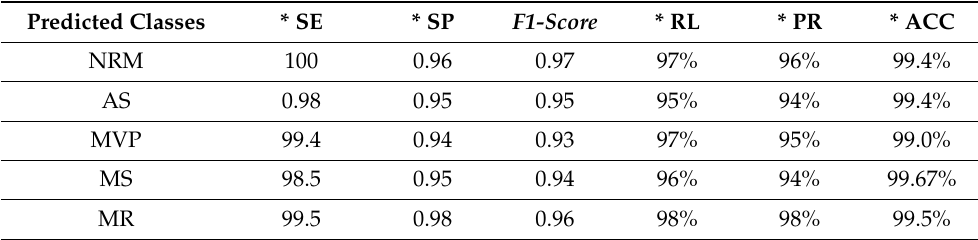
Table 2. Classification results of the Proposed CVT-Trans system model based on 10-fold cross validation on selected dataset. Predicted Classes